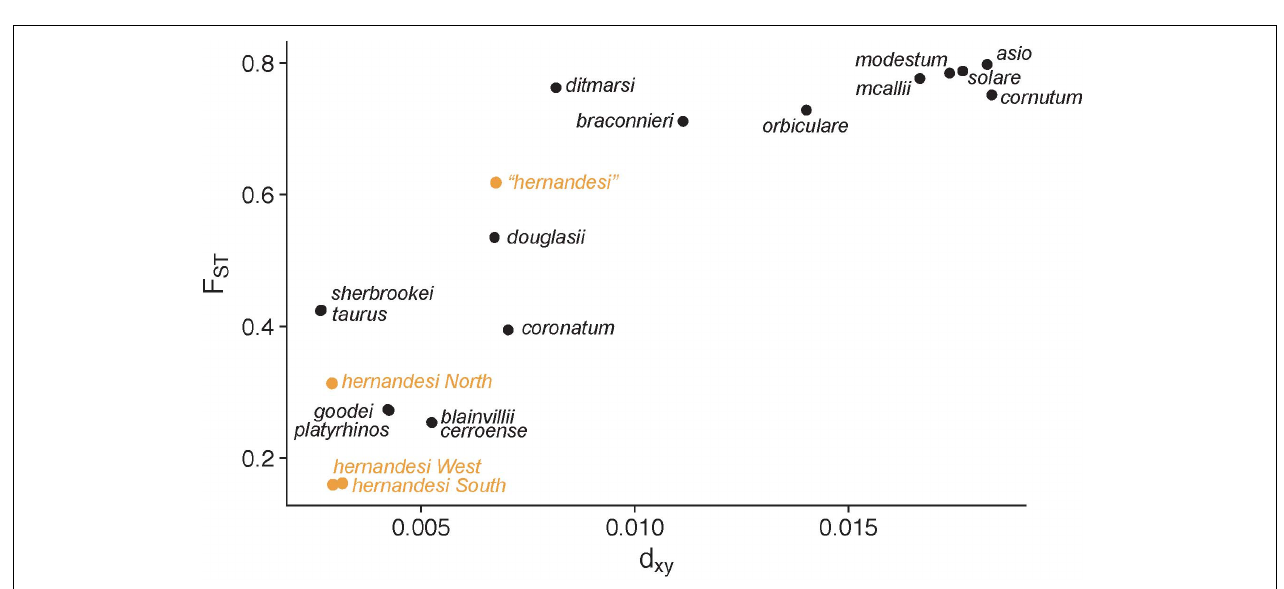
FIGURE 5 | F ST and d xy comparisons among Phrynosoma species (black dots) and four P. hernandesi populations (orange dots). F ST and d xy were estimated among all population-pairs. For each taxon, shown are the lowest F ST and d xy values across all its population comparisons. The three P. hernandesi populations (north, south, west) show markedly lower levels of genetic divergence compared to currently described species. The phylogenetically divergent P. “ hernandesi ” lineage has relatively high levels of genetic divergence in comparison to other described species.